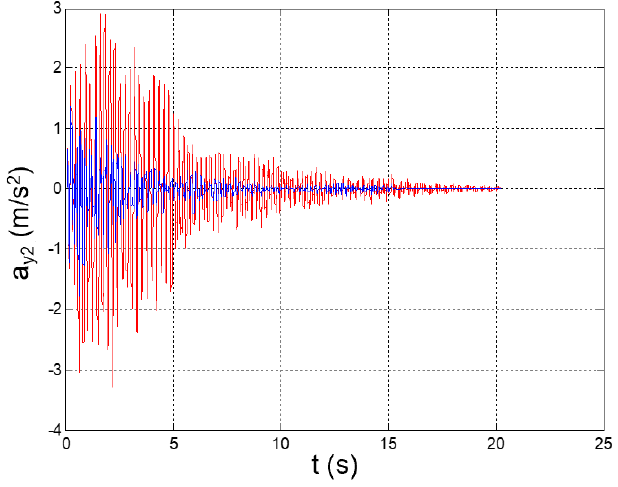
Figure 27. Seismic response, 2nd-floor acceleration (Node 46) with respect to the ground.